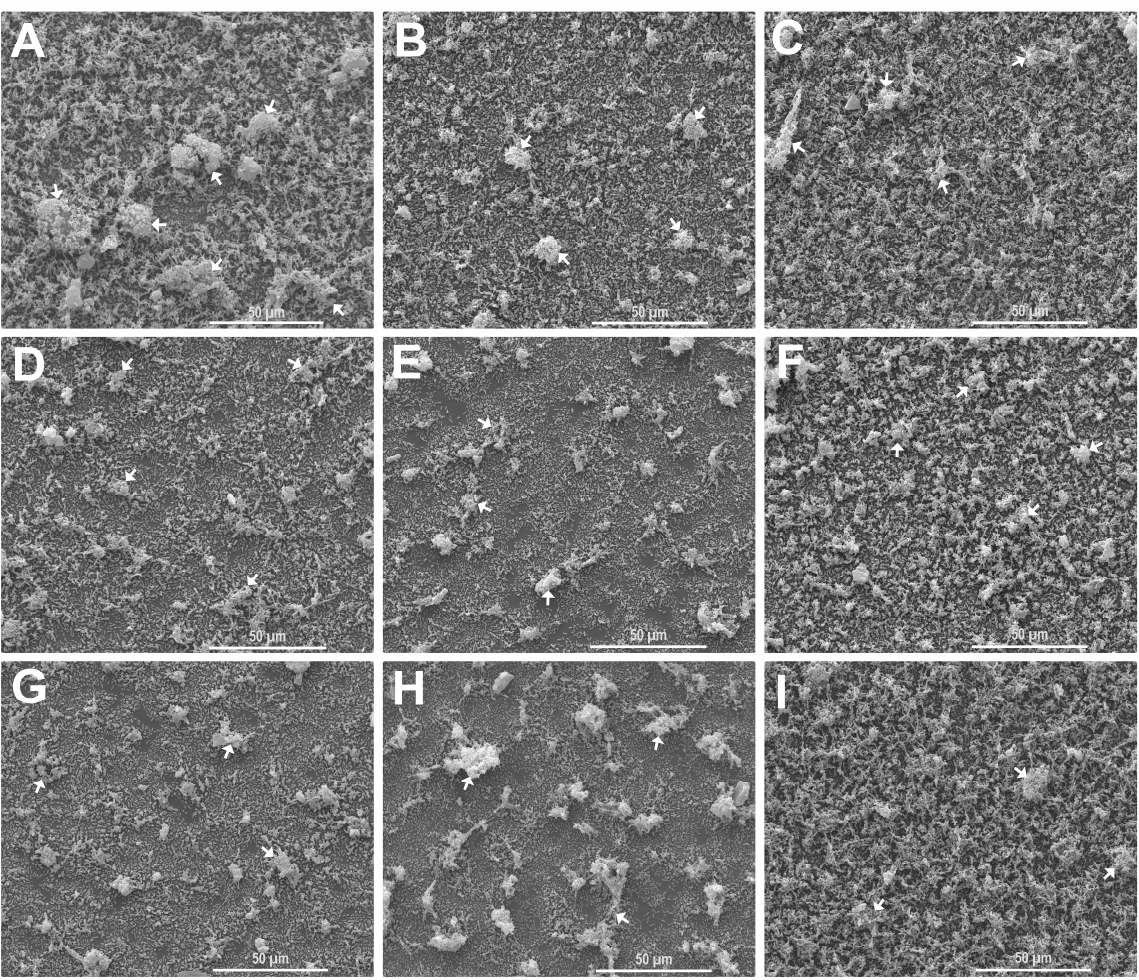
Figure 2 . Low magni fi cation (1600×) scanning electron micrographs of the antibio fi lm e ff ect of oregano-derived antimicrobials and bioAgNP individually and in combination against enteroaggregative Escherichia coli (EAEC 042), showing the amount of bio fi lm on glass surface seen as cell density and cell aggregates. Preformed bio fi lms (24 h) in glass slides were exposed for 24 h to eight di ff erent treatments at subinhibitory concentrations. ( A ) Untreated control (bio fi lm at a later stage, 48 h of growth). ( B ) OEO at 0.3 mg/mL. ( C ) Car at 0.31 mg/mL. ( D ) Thy at 0.12 mg/mL. ( E ) bioAgNP at 7.88 µg/mL. ( F ) Combination of OEO (0.01 mg/mL) plus bioAgNP (3.94 µg/mL). ( G ) Combination of Car (0.15 mg/mL) plus bioAgNP (3.94 µg/mL). ( H ) Combination of Thy (0.06 mg/mL) plus bioAgNP (3.94 µg/mL). ( I ) Combination of Car (0.15 mg/mL) plus Thy (0.06 mg/mL). Micrographs ( A – I ) show cell density and bio fi lm cell clusters. Arrows: cell aggregates.